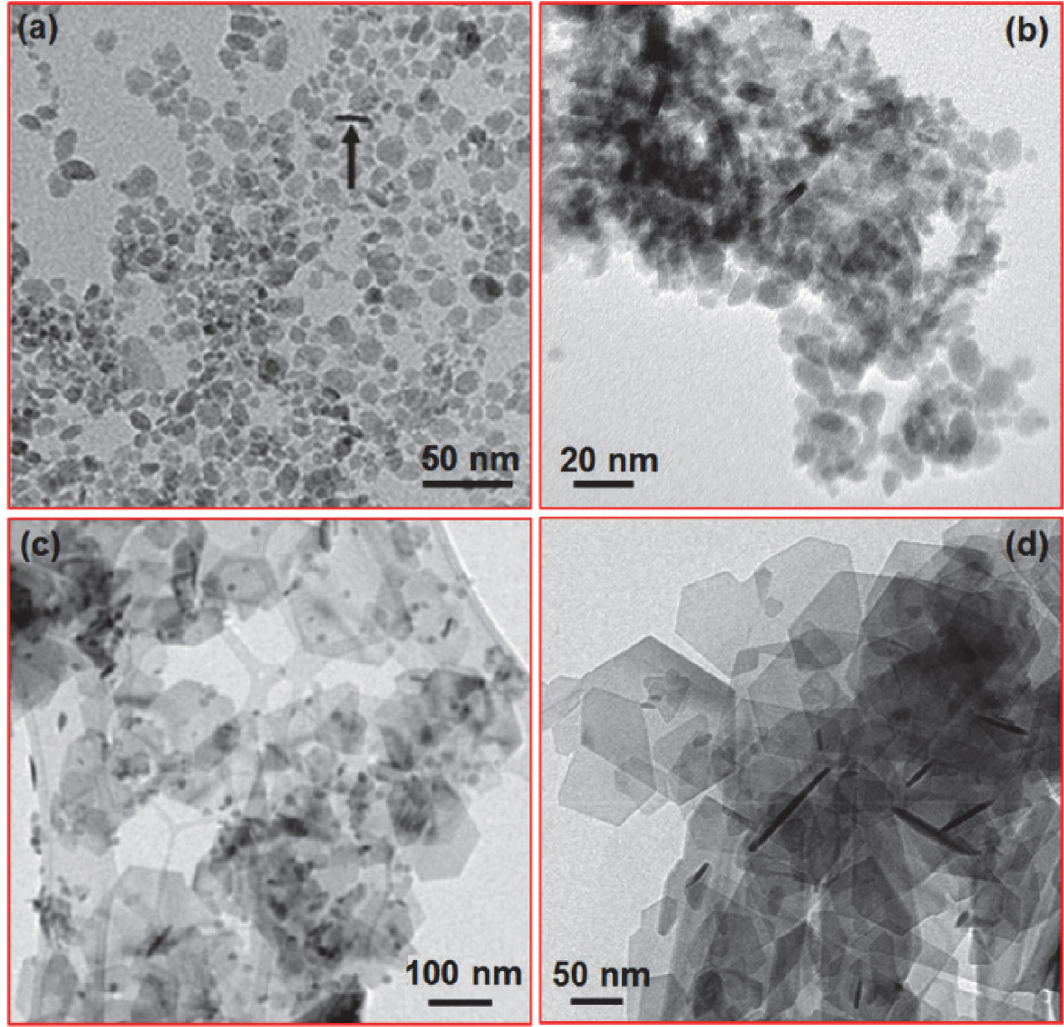
Figure 1. TEM micrographs of the BHF NPLs hydrothermally synthesized for 24 hours at 80 °C (a), and by heating the autoclave to 150 °C (b), 160 °C (c), and 200 °C